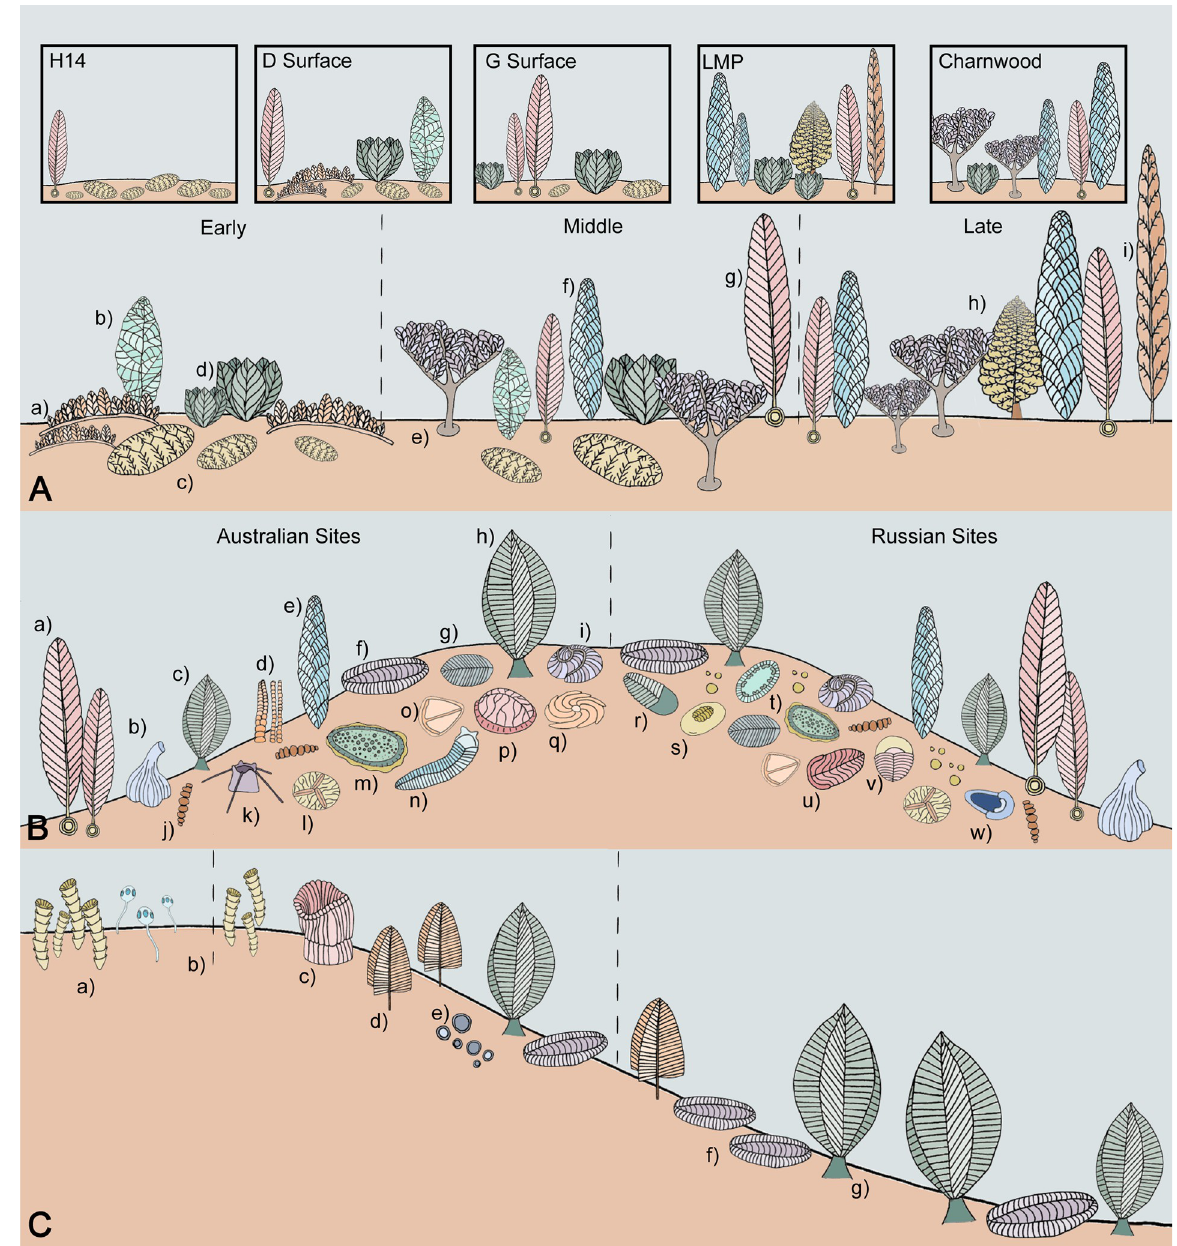
Fig 4. Reconstructions of the Avalon, White Sea, and Nama metacommunities. (A) A reconstruction of the Avalon assemblage showing the proposed stages of a community succession with the actual composition of several surfaces in boxes above. (a) Pectinifrons ; (b) Beothukis ; (c) Fractofusus ; (d) Bradgatia ; (e) Primocandelabrum ; (f) Charnia ; (g) Charniodiscus ; (h) Culmofrons ; (i) Trepassia . ( B) A reconstruction of the White Sea assemblage showing some endemism of taxa to the Russian or Australian sites. (a) Charniodiscus ; (b) Inaria ; (c) Rangea ; (d) Funisia ; (e) Charnia ; (f) Pteridinium ; (g) Dickinsonia ; (h) Rangea ; (i) Tribrachidium ; (j) Palaeopaschinus ; (k) Coronacollina ; (l) Albumares ; (m) Kimberella ; (n) Spriggina ; (o) Parvancorina ; (p) Rugoconites ; (q) Eoandromeda ; (r) Cyanorus ; (s) Onega ; (t) Armillifera ; (u) Andiva ; (v) Yorgia ; (w) Temnoxa . ( C) A reconstruction of the Nama assemblage showing the palaeoenvironmental separation of biomineralising and soft-bodied taxa across a depth profile. (a) Cloudina ; (b) Namacalthus ; (c) Ernietta ; (d) Swartpuntia ; (e) Nimbia ; (f) Pteridinium ; (g) Rangea . Taxa and environmental separation are not to scale. LMP AU : PleasedefineLMPinFig 4 ifthisindeedisanabbreviation : , Lower Mistaken Point surface.